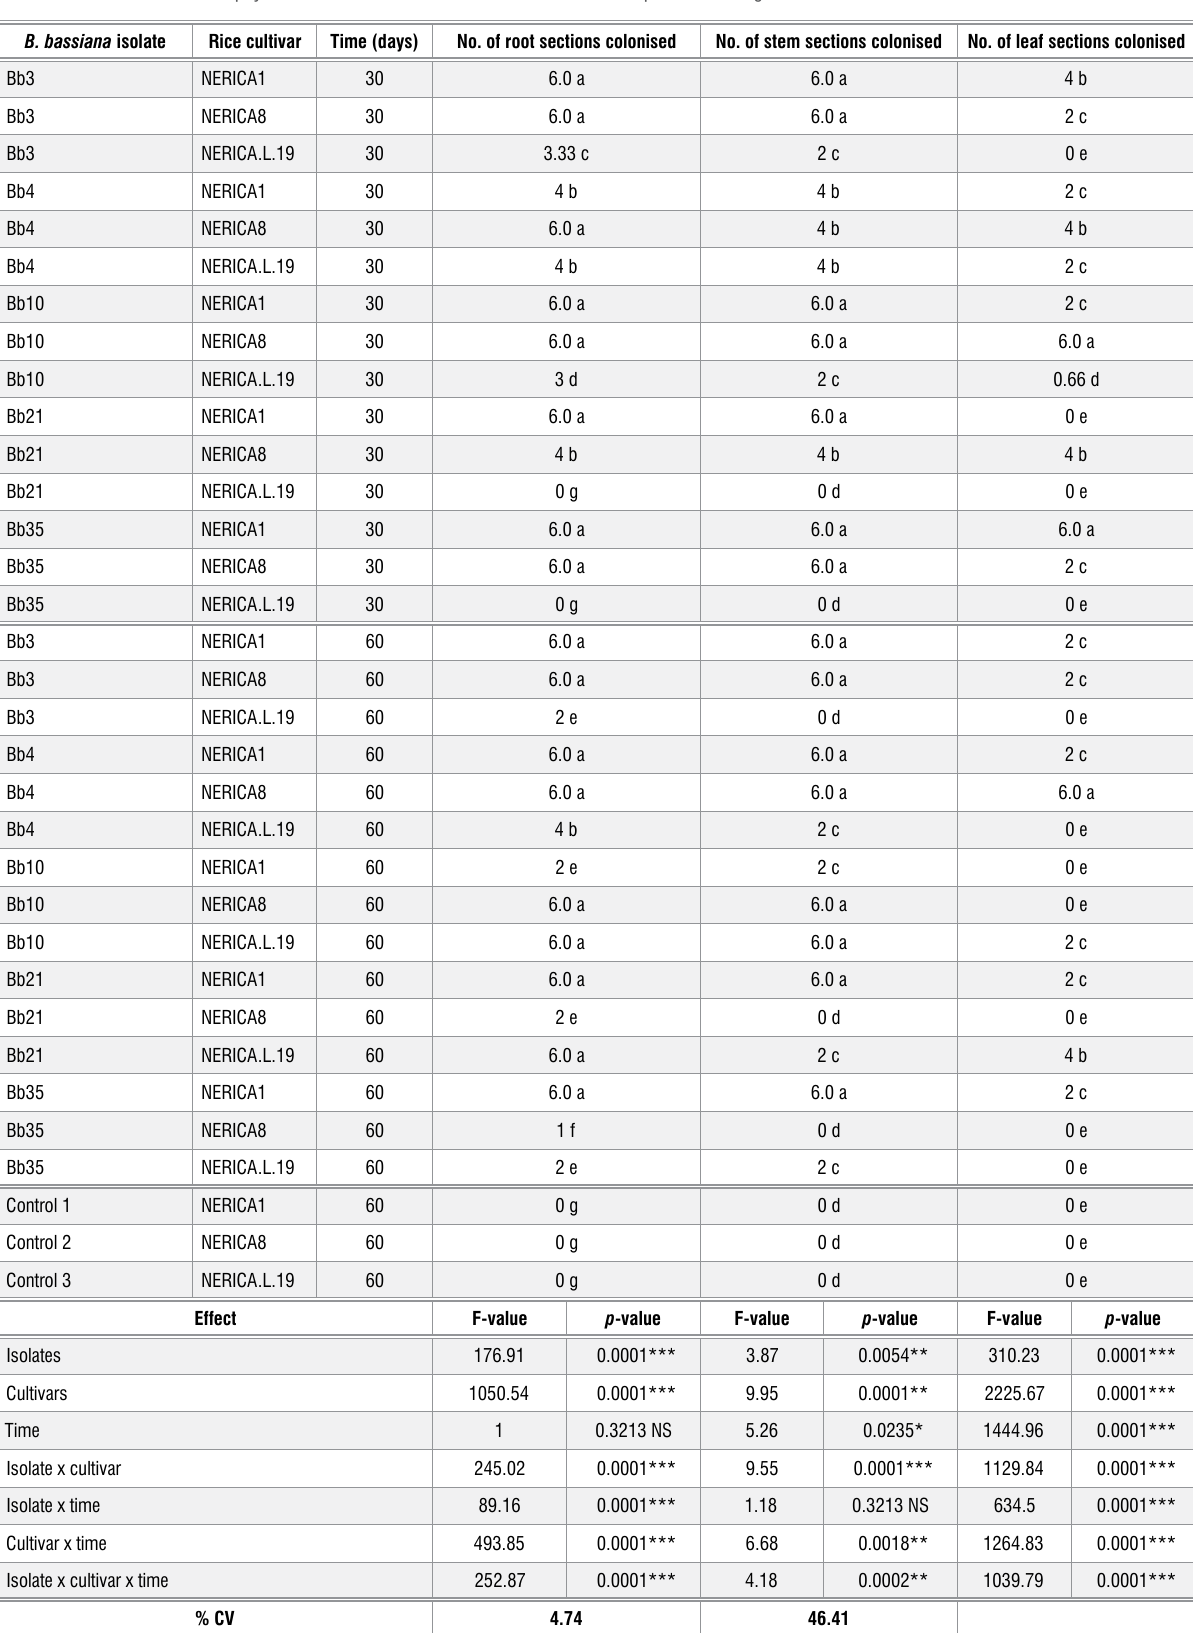
Table 1: Evaluation of endophytic behaviour of Beauveria bassiana strains in rice plants following seed inoculation B. bassiana